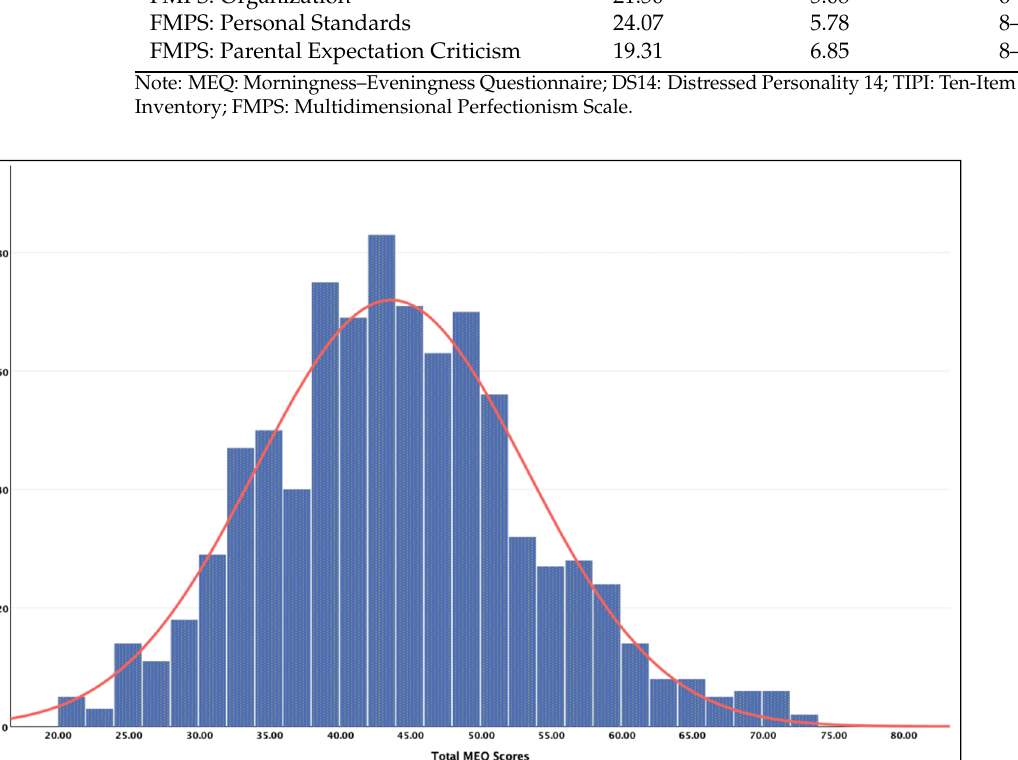
Table 2. Correlations between chronotype preference and personality traits. 1.